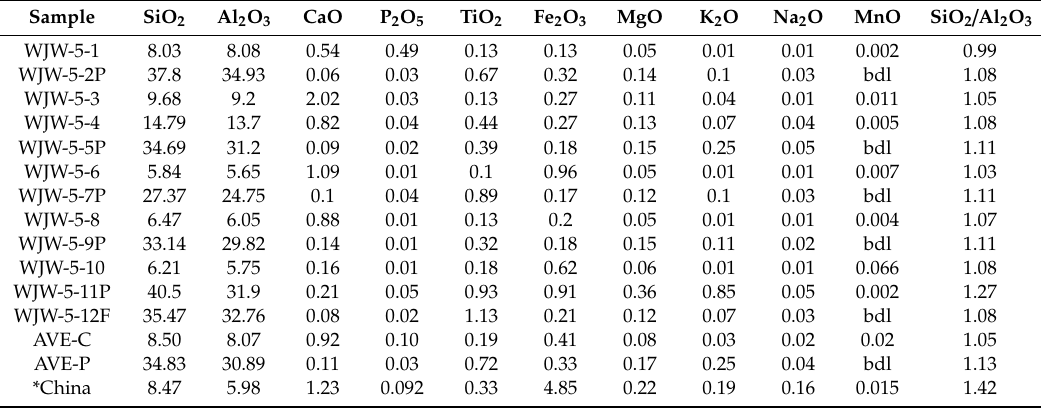
Table 2. Proportion of major element oxides in the Wujiawan coal samples and their comparisons with the mean value of Chinese coals (Values are in wt% on a whole coal